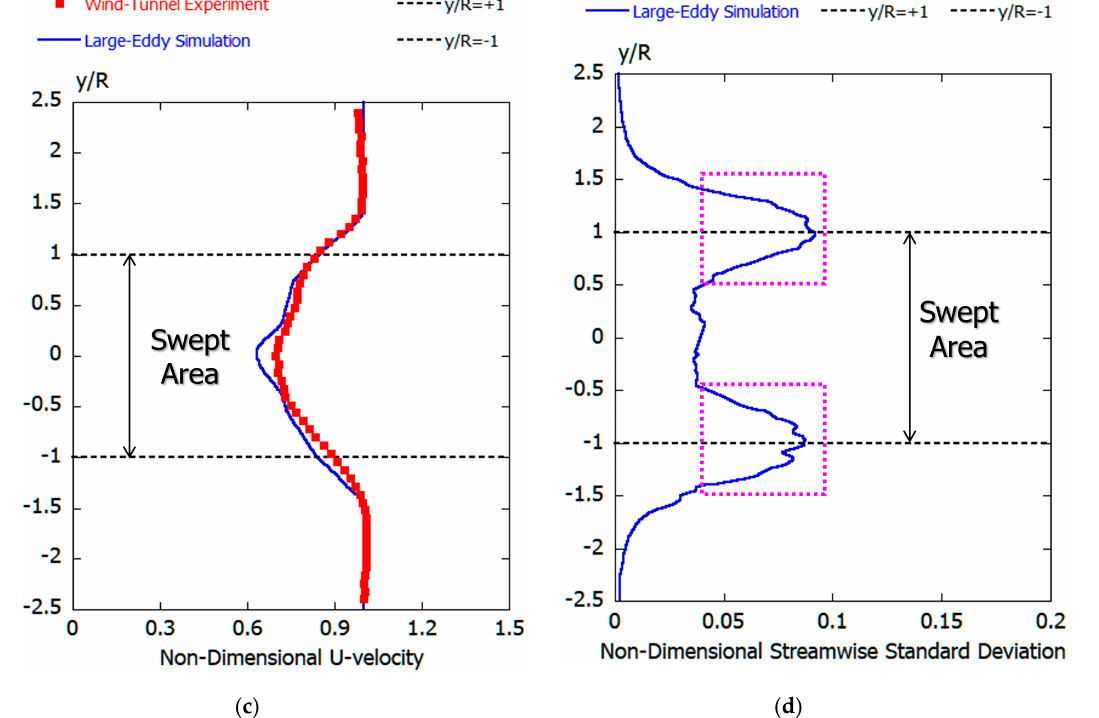
Figure 11. Distribution comparison of turbulence statistics: ( a ) nondimensional U-velocity at x = 0.5 D; ( b ) nondimensional streamwise standard deviation at x = 0.5 D; ( c ) nondimensional U-velocity at x = 8.0 D; and ( d ) nondimensional streamwise standard deviation at x = 8.0 D.